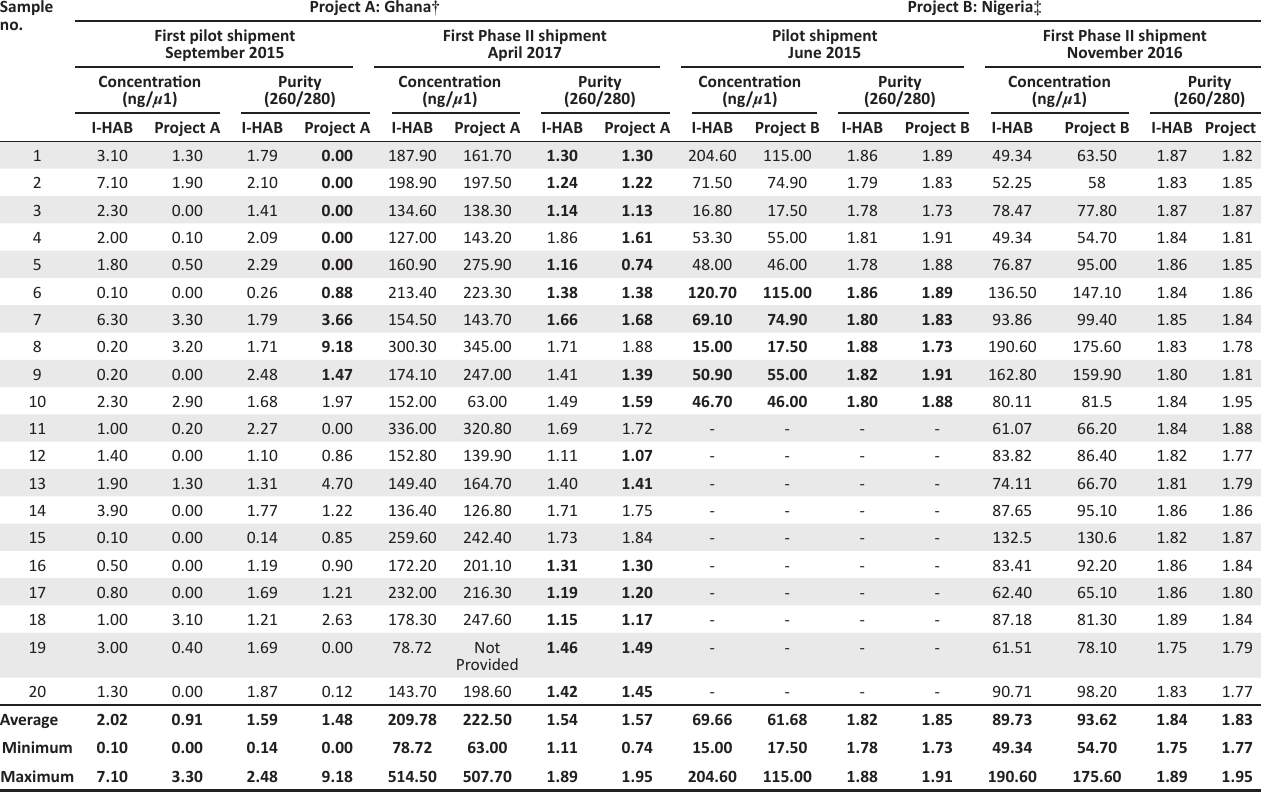
TABLE 2: DNA quality control results for Projects A and B. Sample